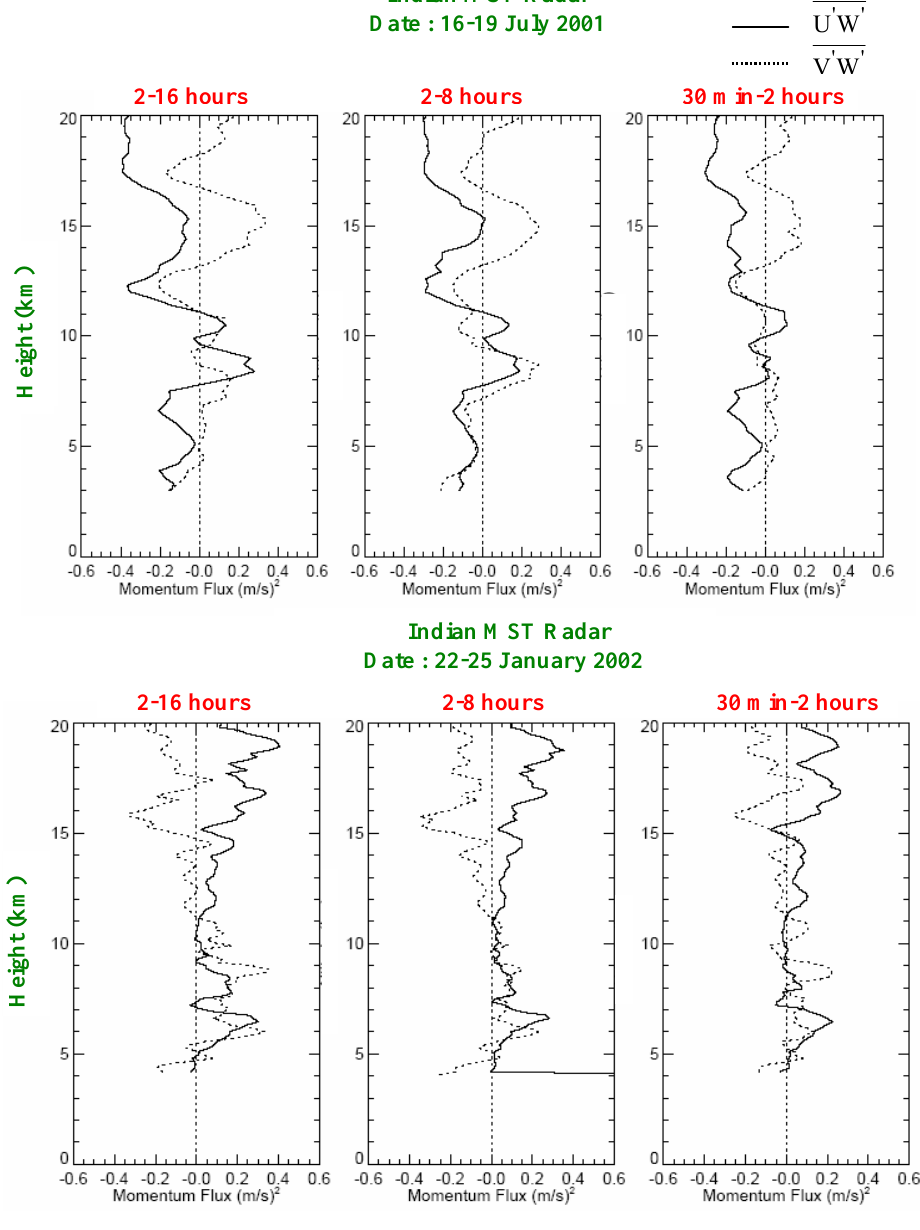
Fig. 14. Vertical profiles of zonal and meridional momentum fluxes estimated from the four beam method for different frequency bands (2–16h, 2–8h, 30min–2h) during 16–19 July 2001 (upper panel) and 22–25 January 2002 (lower panel). The solid line represents zonal momentum flux and the dotted line represents the meridional momentum flux.